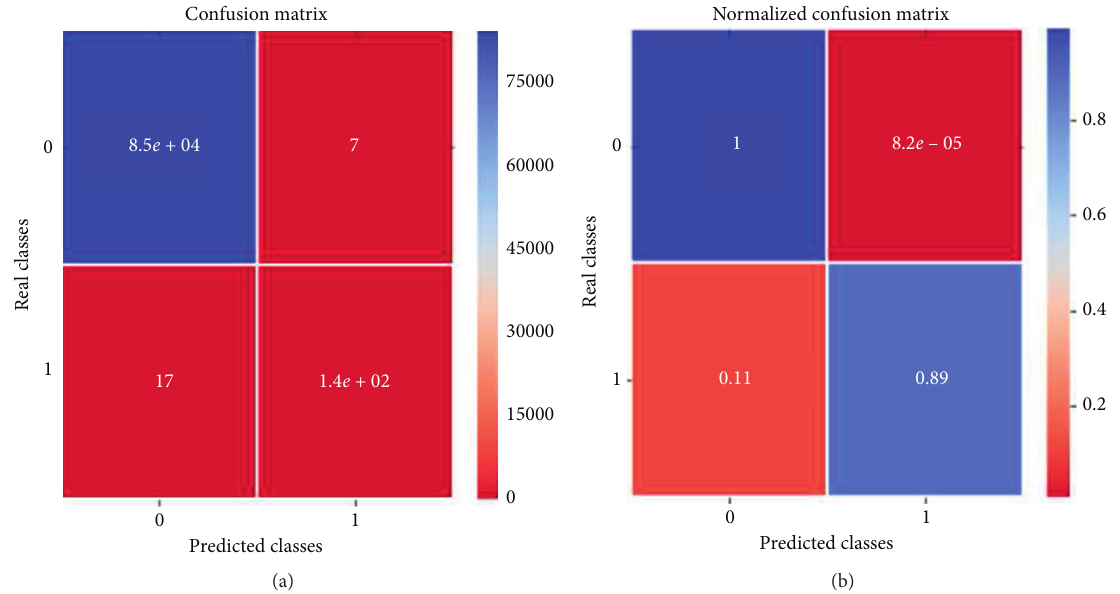
Figure 15: (a) Confusion matrix and (b) normalized confusion matrix for